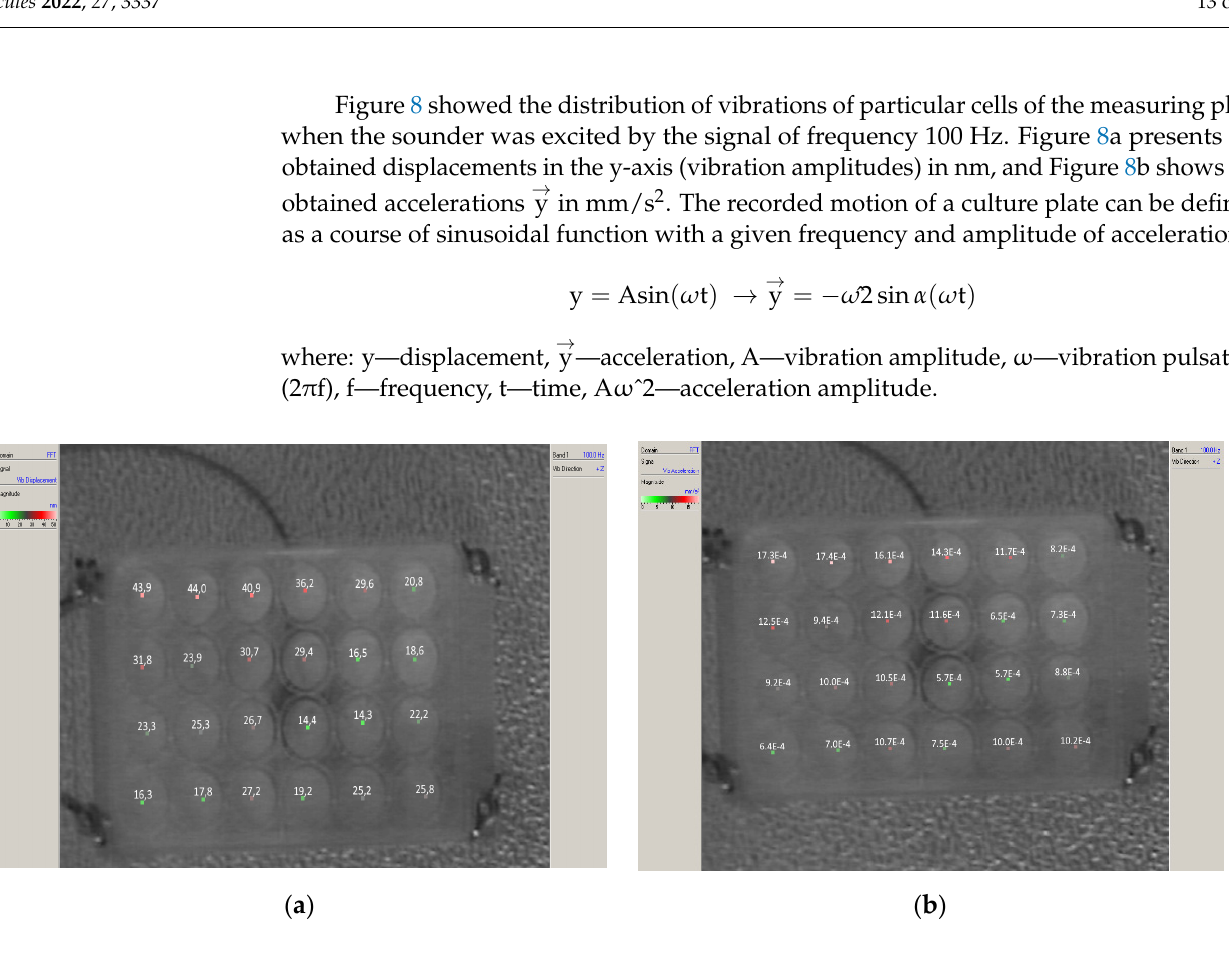
Figure 8. Distribution of vibrations of individual cells of the plate for f = 100 Hz; ( a )—vibration amplitude of plate cells [nm], ( b )—acceleration of plate cells [mm/s 2 ].